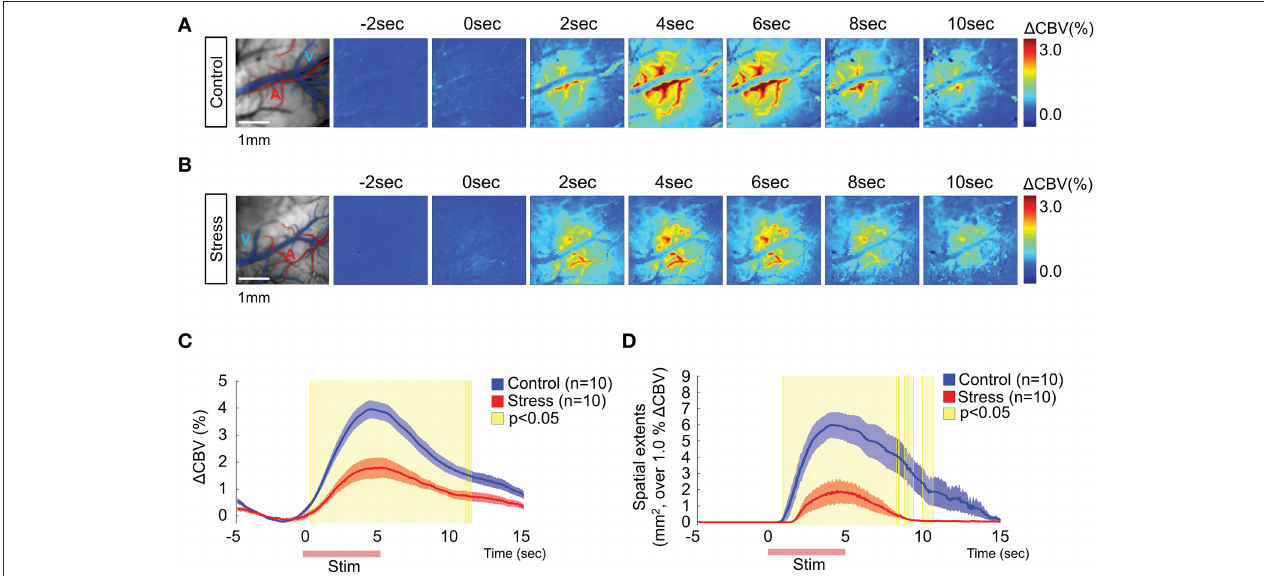
FIGURE 2 | Hemodynamic responses in the somatosensory cortex upon 1mA hindpaw electrical stimulation. Representative images of the hemodynamic responses from a non-stressed rat (A) and a 3-week chronically stressed rat (B) . The activation maps show the changes in the cerebral blood flow every other second following hindpaw electrical stimulation using color mapping. (C) The time series analysis of maximum 1 CBV in the control and stressed groups. (D) The time series analysis of the spatial extent of changes surpassing 1% 1 CBV. The red lines on the x-axis in (C,D) indicate the hindpaw stimulation period. The yellow-shaded areas on the plots of (C,D) represent the frames that showed significant changes between the control group and the stress group [Control ( n ) = 10 and Stress ( n ) = 10, Mann–Whitney test, p < 0.05